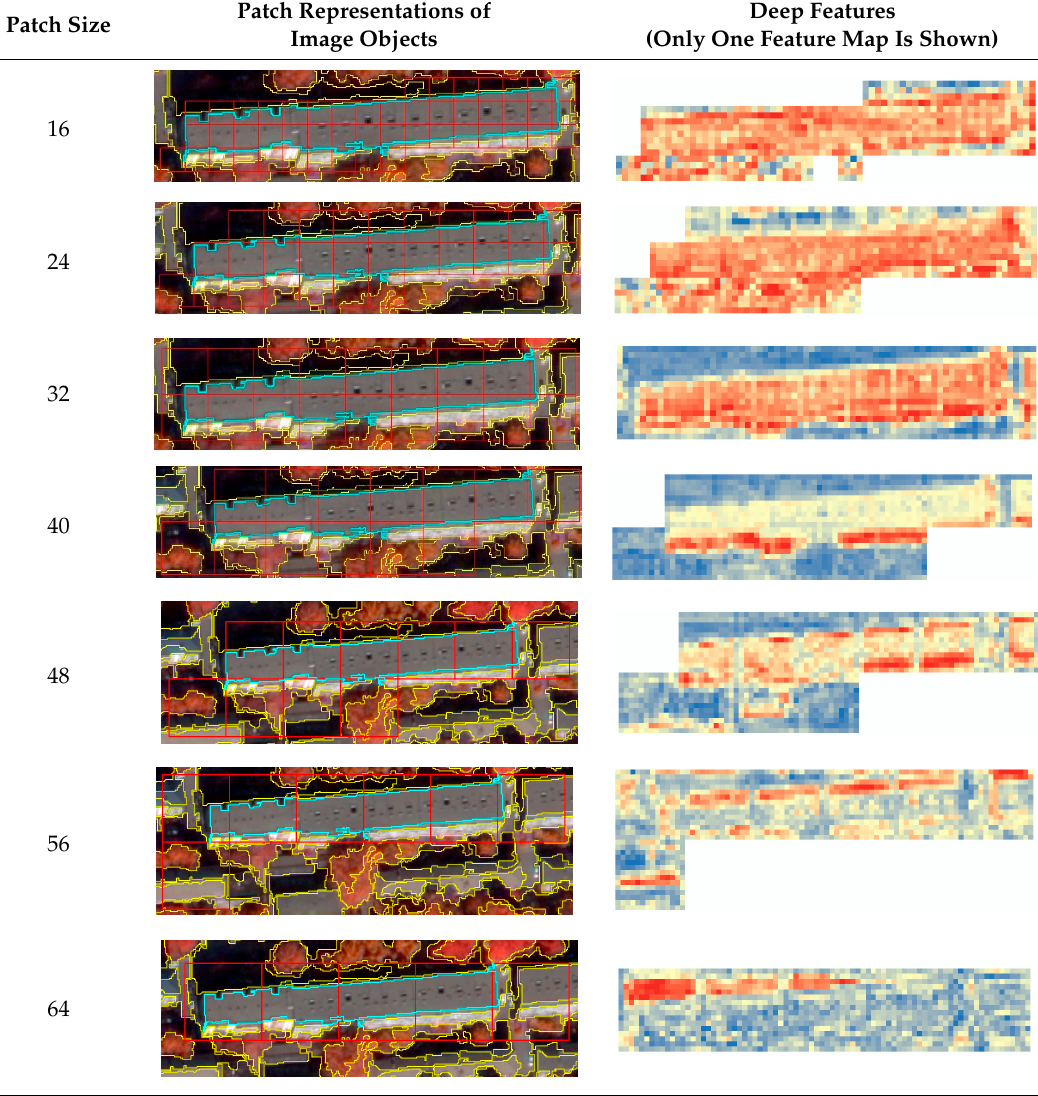
Figure 17. The variation of producer accuracies of Buildings ( a ), Vegetation ( b ), Roads ( c ), Water ( d ), Shadows ( e ) and Bare soils ( f ) over patch sizes (the horizontal axis refers to patch size, the vertical axis refers to accuracies, while different curves represent different segmentation scales).